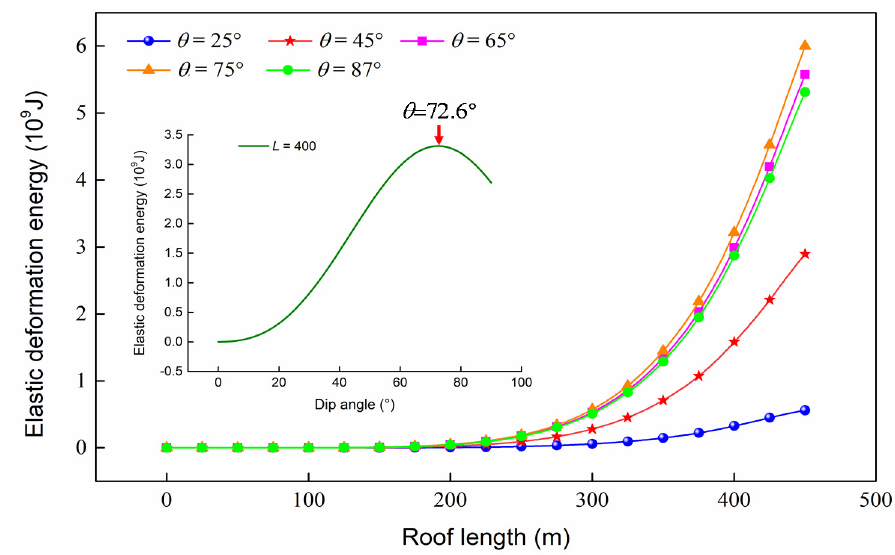
Figure 7. Distribution of the elastic deformation energy (EDE) of the roof for di ff erent dip angles of coal seams.